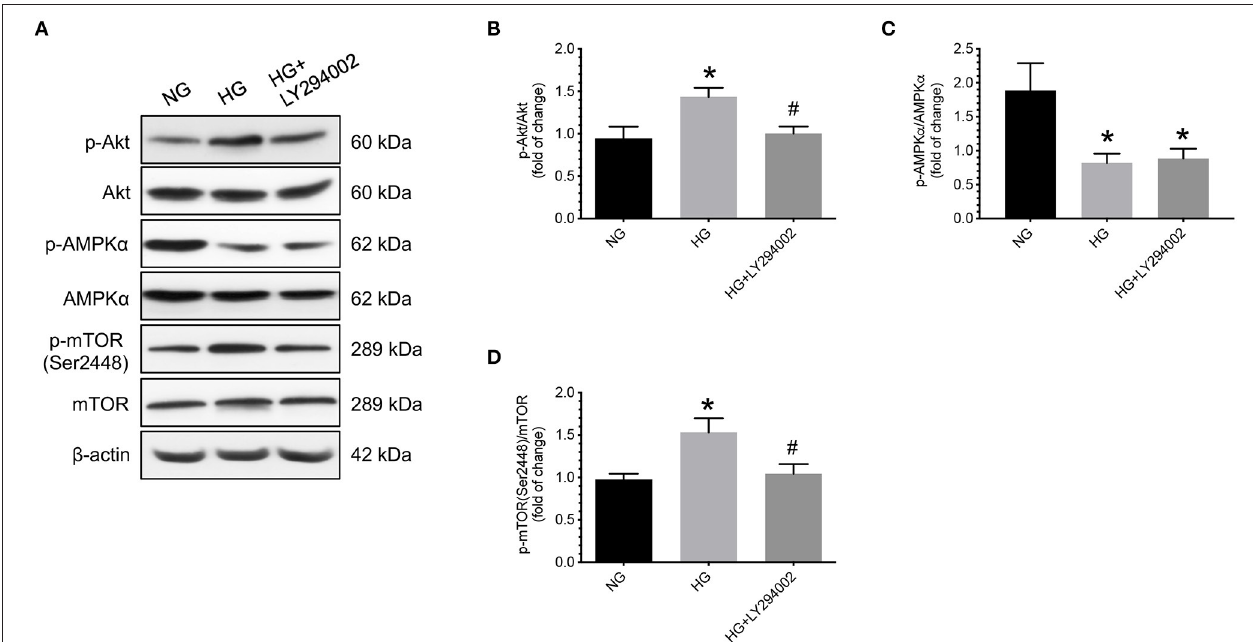
FIGURE 6 | Effects of LY294002 on phosphorylation levels of AMPK α and mTOR in human cytotrophoblast cells under hyperglycemic conditions. Under hyperglycemic conditions, administering LY294002, a specific inhibitor of PI3K/Akt, caused a significant decrease in the levels of p-mTOR (Ser2448) compared to the vehicle control groups. Nevertheless, no significant differences in the levels of total and phosphorylated AMPK α were found between cells treated with or without LY294002. (A) Representative blots show the levels of phosphorylated and total forms of Akt, AMPK α , and mTOR. β -actin was used to normalize loading variability. (B–D) Data are presented as mean ± SEM; n = 9 for each group. *, P < 0.05, compared to cells cultured at normoglycemic conditions; # , P < 0.05, compared to vehicle controls; based on one-way analysis of variance followed by Tukey’s post-hoc test. NG, normoglycemic conditions; HG, vehicle controls under hyperglycemic